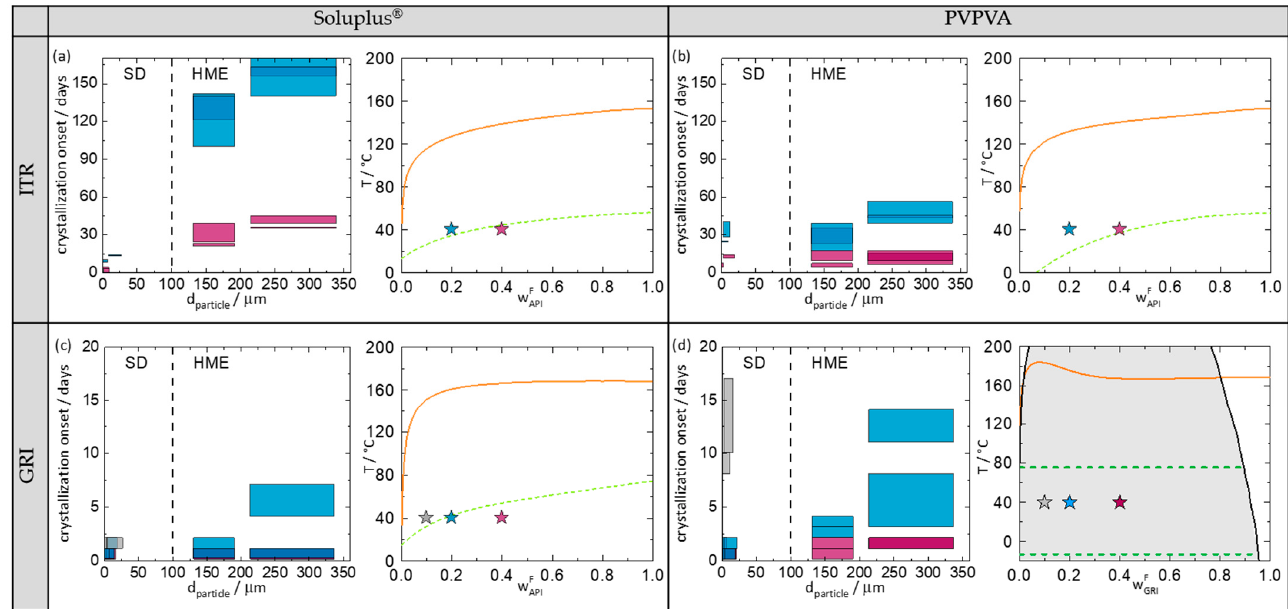
Figure 5. ( a ) ITR/Soluplus ® , ( b ) ITR/PVPVA, ( c ) GRI/Soluplus ® , and ( d ) GRI/PVPVA. Grey symbols denotes ASDs with 10 wt.% API, blue symbols denotes ASDs with 20 wt.% API, and purple symbols denotes ASDs with 40 wt.% API. Left site of all subfigures: Crystallization-onset time of ASDs stored at 40 °C/75% RH in days as function of the particle size. The height of the bars marks the period between the last amorphous and first crystalline PXRD measurement (crystallization-onset time). If the crystallization-onset time of two measurements overlap, the bars are superimposed (e.g., darker blue). The width of the bars indicates the particle-diameter range covering 80% of the particles of the ASD. Right site of all subfigures: predicted phase diagrams at 75% RH. The solid lines are PC-SAFT-predicted solubility lines. The dashed lines in ( a - c ) are the predicted glass-transition temperatures of the ASDs. The grey area in ( d ) denotes the region of amorphous phase separation calculated with PC-SAFT. The two dashed lines in ( d ) represent the glass-transition temperatures of the two phases (API-rich phase and API-poor phase) evolving in the ASD at 40 °C.